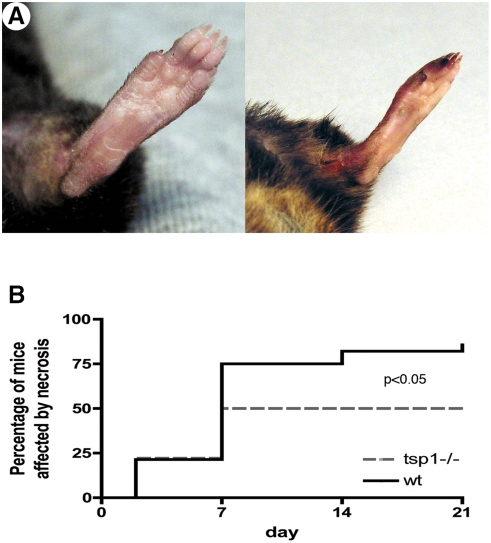
Clinical necrosis is reduced in tsp-1−/− mice.(A) Pictures show mice either protected from necrosis (left) or affected by necrosis (right). (B) Cumulative incidence of necrosis was followed during 21 days after ischemia in both wt and tsp-1−/− mice and represented as Kaplan-Meier estimates (n = 19; p<0.05 tsp-1−/− vs. wt).